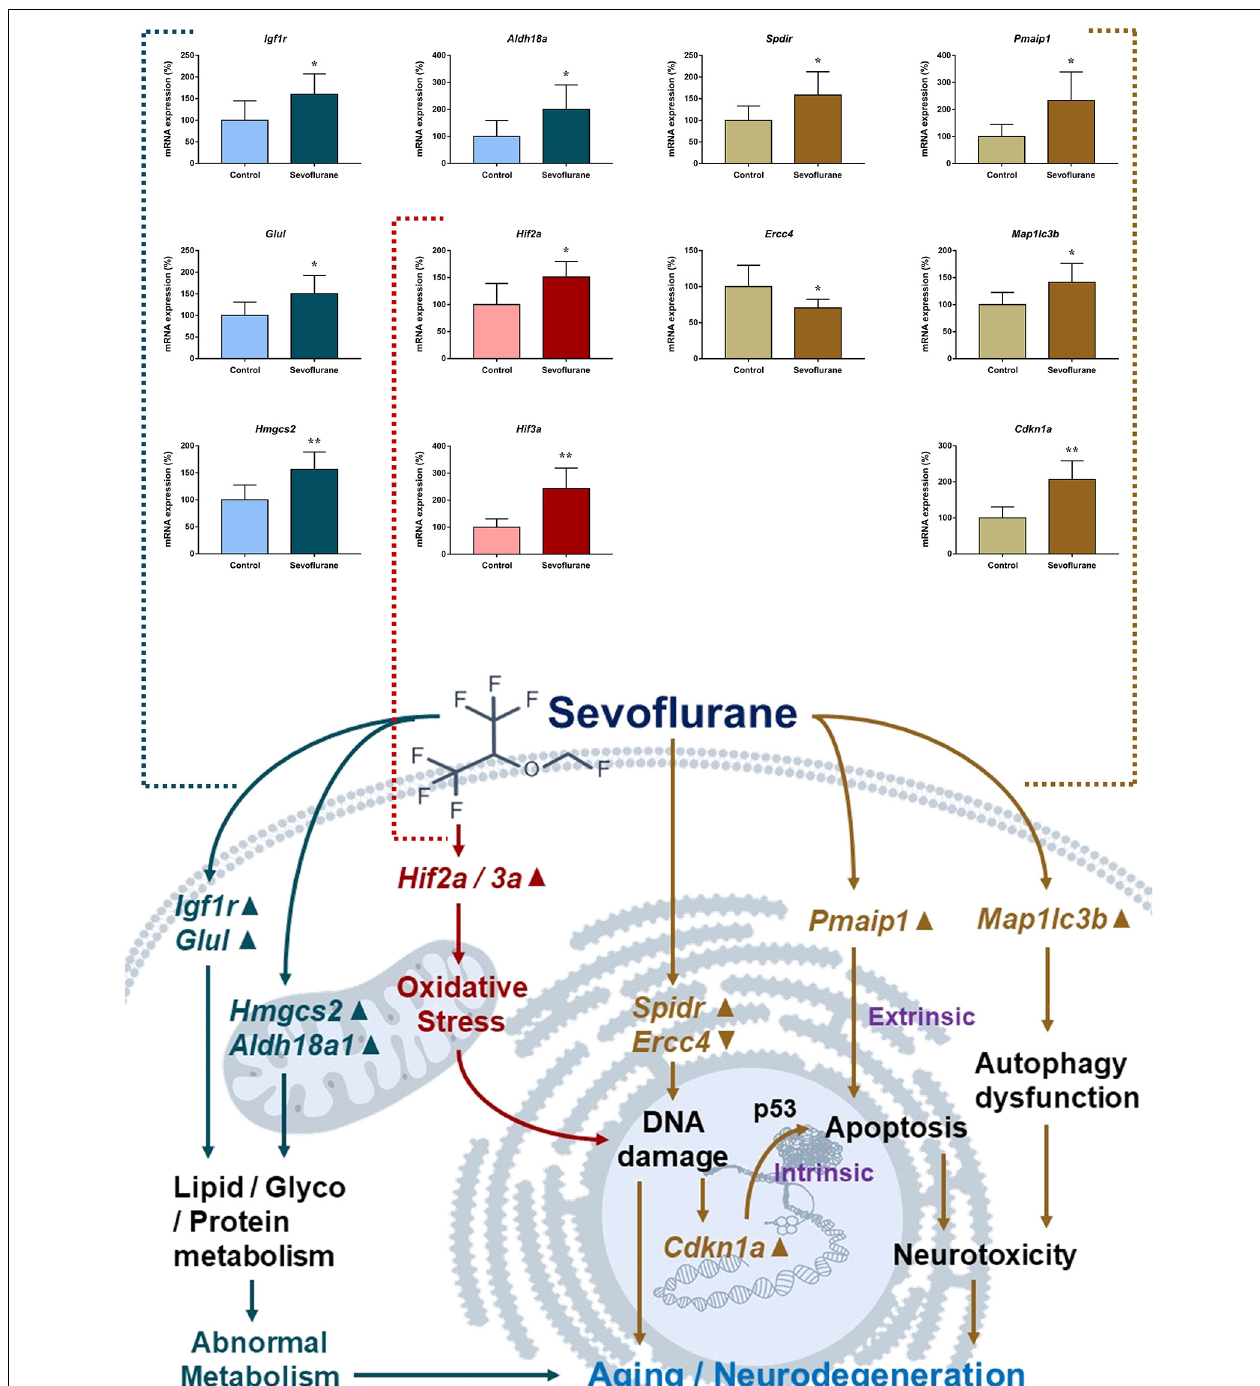
FIGURE 8 | Hypothetical pathway related to metabolism identified with altered DNA expression in the sevoflurane anesthesia group in comparison with the control group. Regular triangle represents genes up-regulated; inverted triangle represents genes down-regulated; graphs show the difference in expression of Spdir , Pmaip1 , Ercc4 , Map1lc3b , and Cdkn1a were for sevoflurane anesthesia group and controls (* p < 0.05; ** p < 0.01).